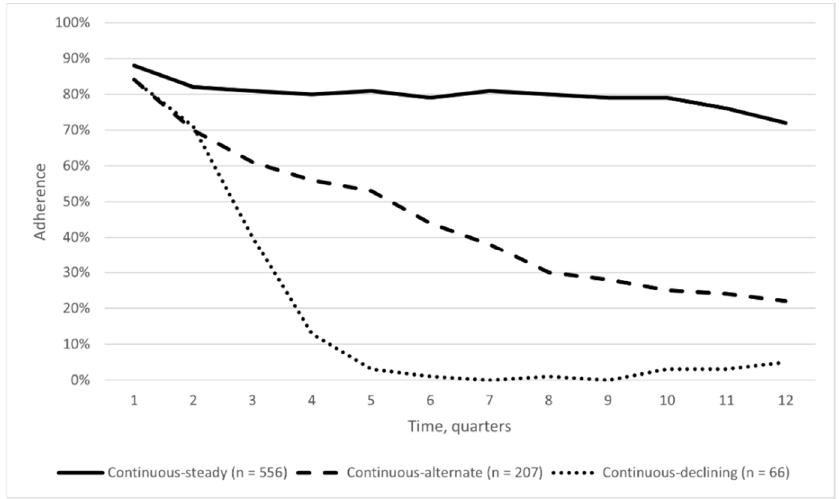
Figure 4. Sub-trajectories of adherence to biologic DMARDs in the second-phase analysis.